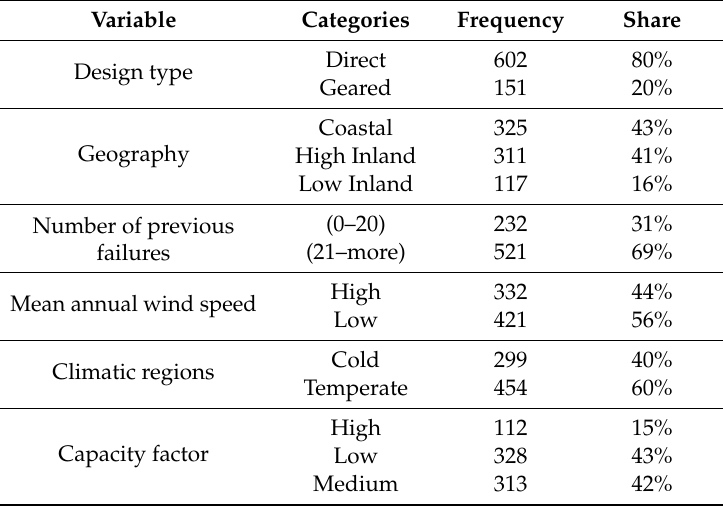
Table 1. Summary of number of data points based on